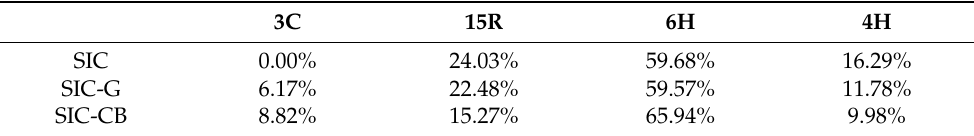
Table 2. Participation of individual polytypes in the structure of SiC 20/80-type